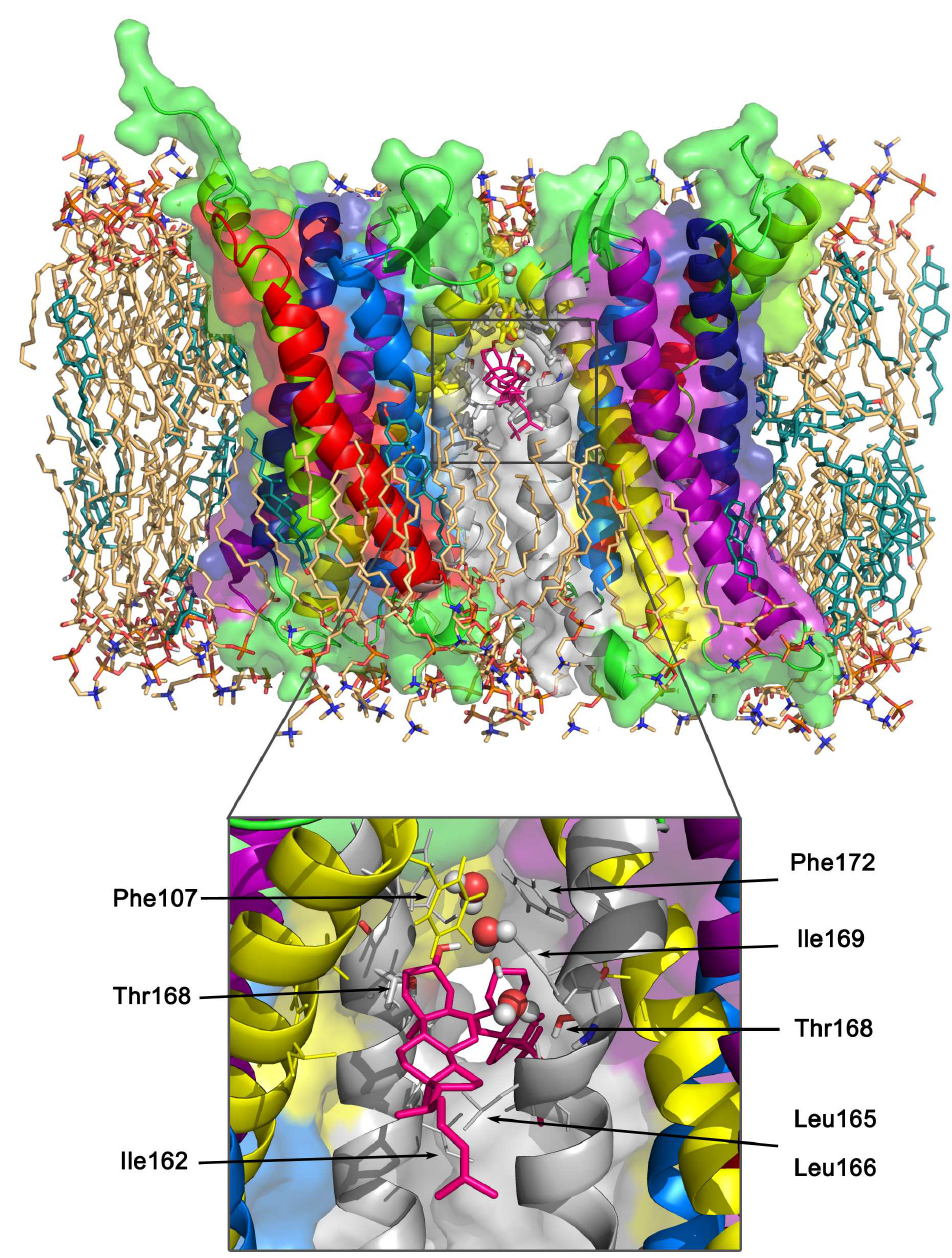
Fig 5. Cholesterol intercalation at the cholesterol-induced dimeric interface. TM3,4/TM3,4 dimer F with two symmetrically intercalated cholesterols (shown as hotpink sticks) (structure after 100 ns atomistic MD simulation). The surrounding membrane is shown in light orange (POPC) and teal (cholesterol) sticks. In the insert, the two intercalating cholesterol moleculesare highlightedtogether with their surroundings and water molecules (shown as spheres) forming bridgesbetween the cholesterols and between Thr168 and cholesterol.